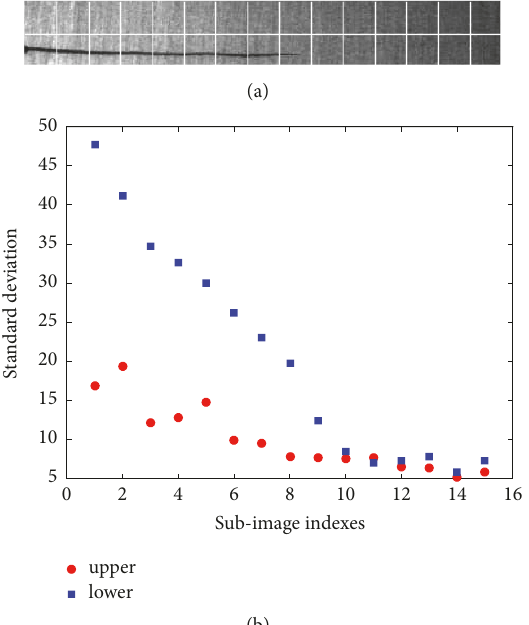
Figure 5: (a) Division of subimages. (b) Distribution of the subimages grayscale standard deviation.